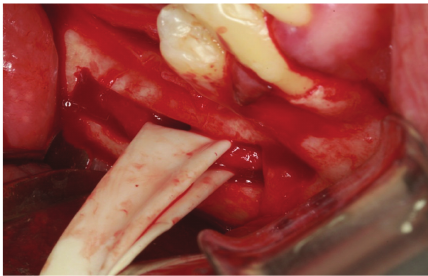
Figure 26: Osteotomy.